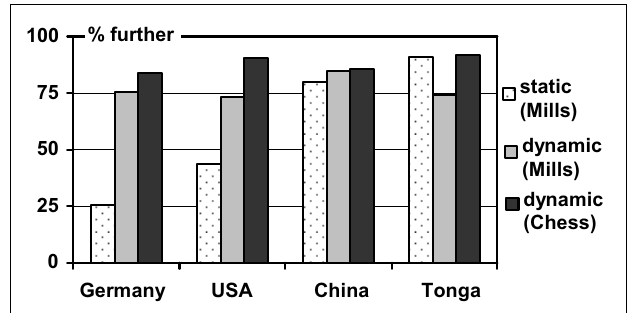
FIGURE 4 | Percentage of individuals assigning FRONT further away from the observer in space (Mills task, cf.Table 4) and time (cf.Table 3).